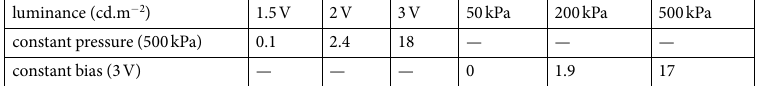
Table 2. Summary of luminance of micro-structured solution-processed light-emitting